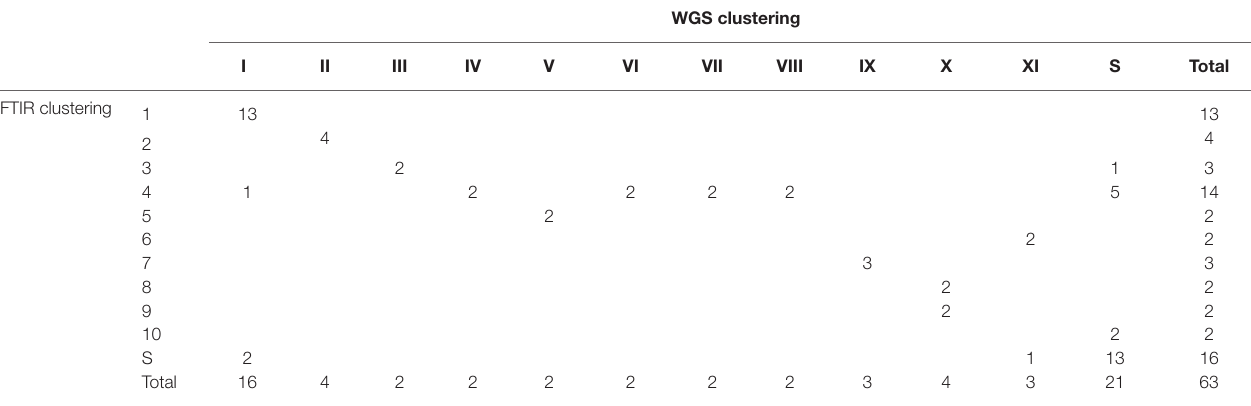
TABLE 2 | Contingency table comparing FTIR clustering (1–10) vs. WGS clustering (I–XI) as the reference